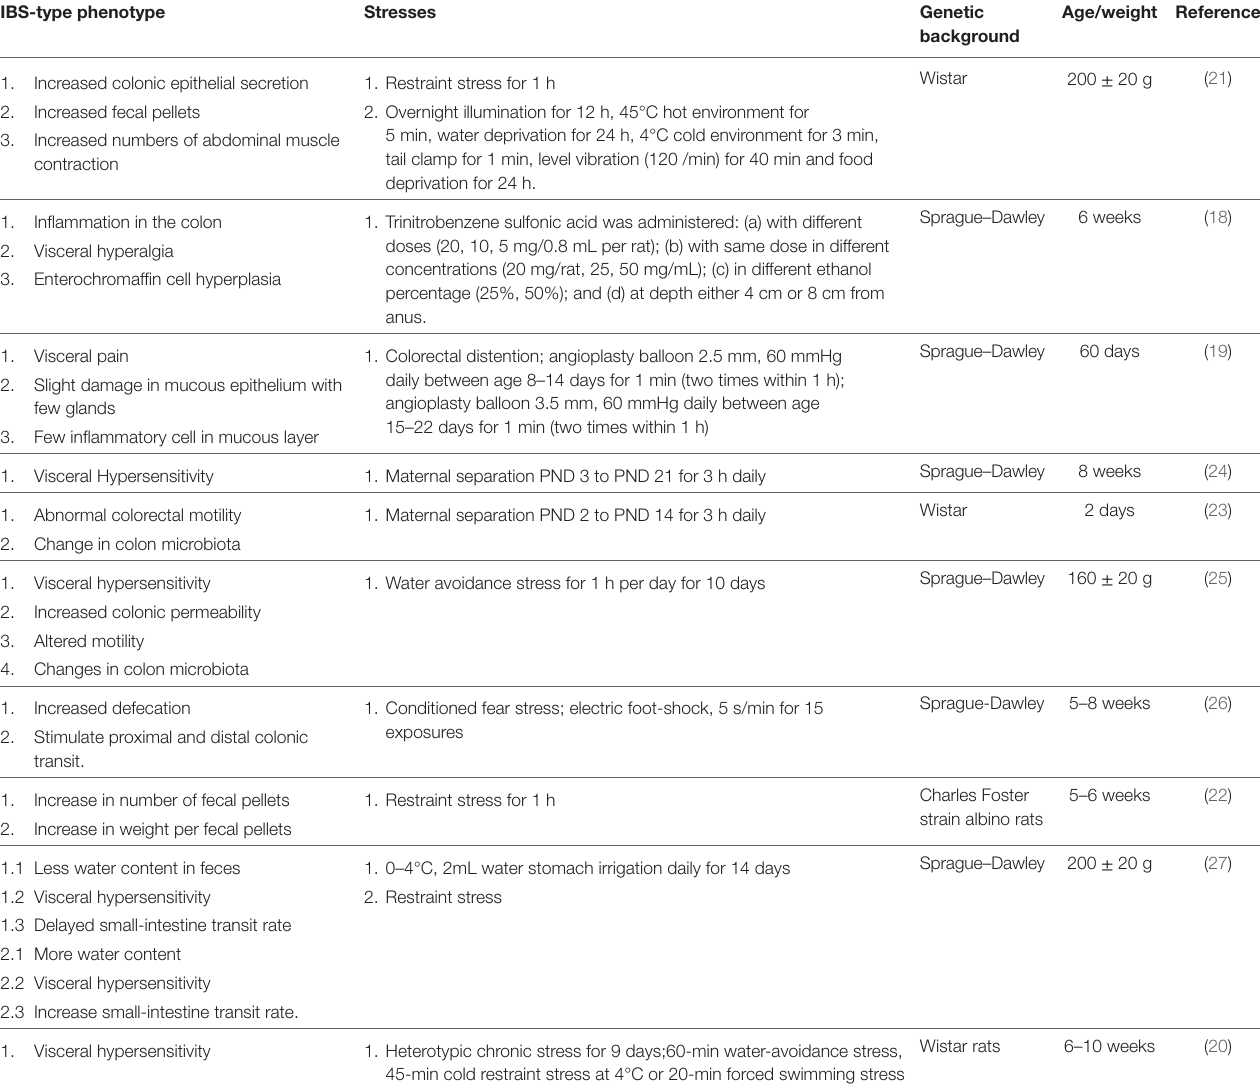
TABLe 1 | Stress-induced irritable bowel syndrome (IBS) animal model in the current literature. iBS-type